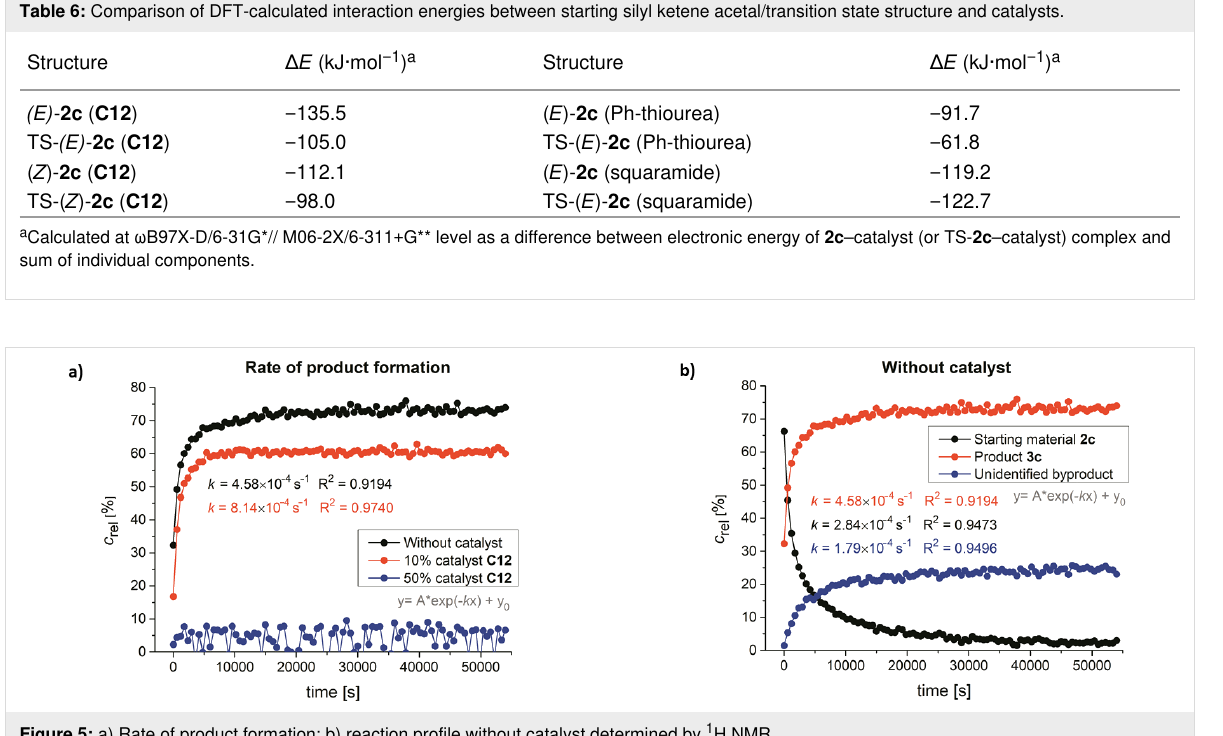
Figure 5: a) Rate of product formation; b) reaction profile without catalyst determined by 1 H